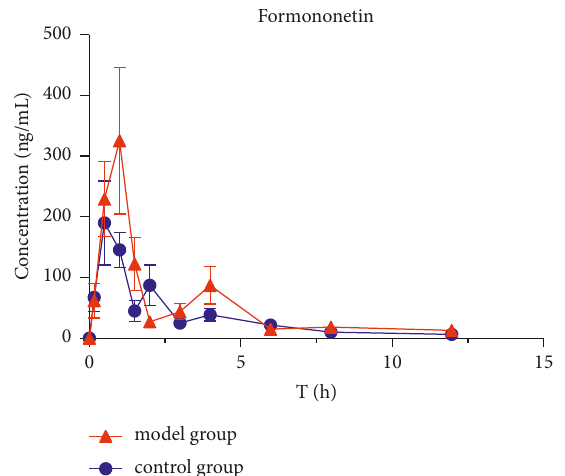
Figure 10: Concentration-time profiles of formononetin after HQD administration ( x ± SD, n � 8).